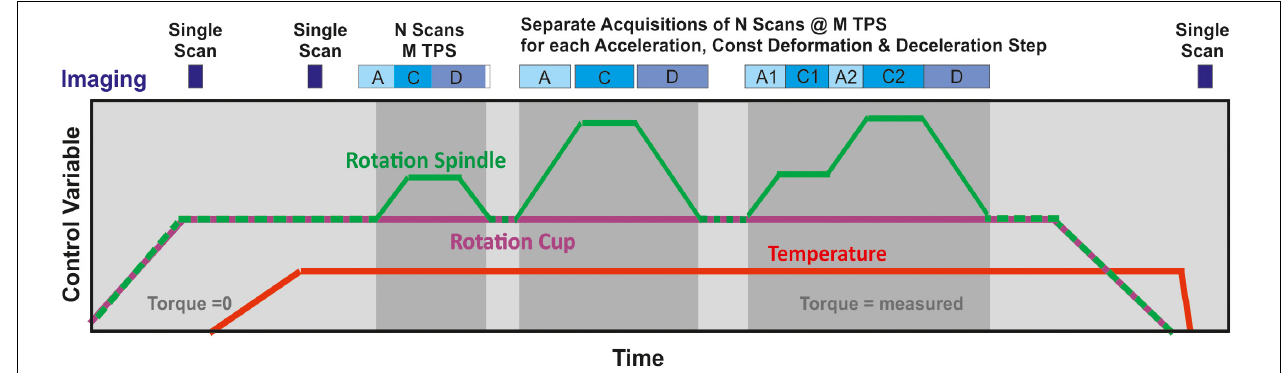
FIGURE 4 | Acquisition schedules typically used with the XRheo, showing how single scans of the sample pre- and post-experiment are collected, and how the timing of the repeated multi-scan acquisitions can fit in a deformation cycle. The full deformation cycle can either be captured as a single scan, or as a series of condition specific data sets for the acceleration (A), constant deformation (C) and deceleration stages (D). The maximum TPS used in an experiment would not usually change, but TAR can be adjusted according to the deformation, as can the total number of tomographies being collected. Some beamlines require time between scans to download the data to network storage. This can be achieved during periods of zero torque (i.e., spindle moving with sample, no deformation) or during extended periods at any of the constant deformation stages. Experiment duration is dependent only on the acquisition capability of the beamline. Heating rates of 20 ◦ C/min were used to best control glass behavior (Wadsworth et al., 2019). Cup rotation speed is fixed by image acquisition, and rotation speed of the spindle calculated accordingly with a minimum differential determined by the sensitivity of the rheometer control (0.01 rpm differential at the highest cup rotation speed used in these experiments). The strain rates within the sample are therefore controlled by the spindle rotation speed and the cup and spindle diameters.